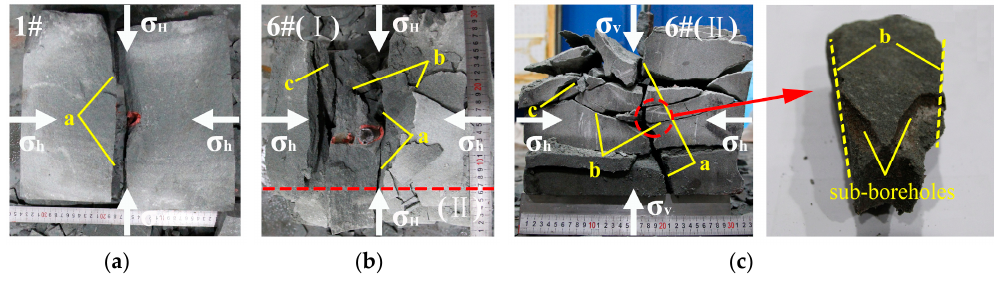
Figure 4. Images showing the samples after fracturing. ( a ) The sample #1 after conventional fracturing; ( b ) The sample #6 after tree-type fracturing; ( c ) The partial enlarged drawing of sample #6. The fracture morphology of sample #4 is similar to that of sample #1 , and the fracture morphologies of samples #2